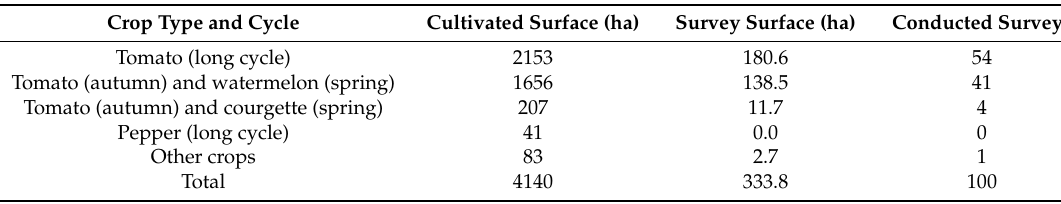
Table 1. Sample distribution per crop